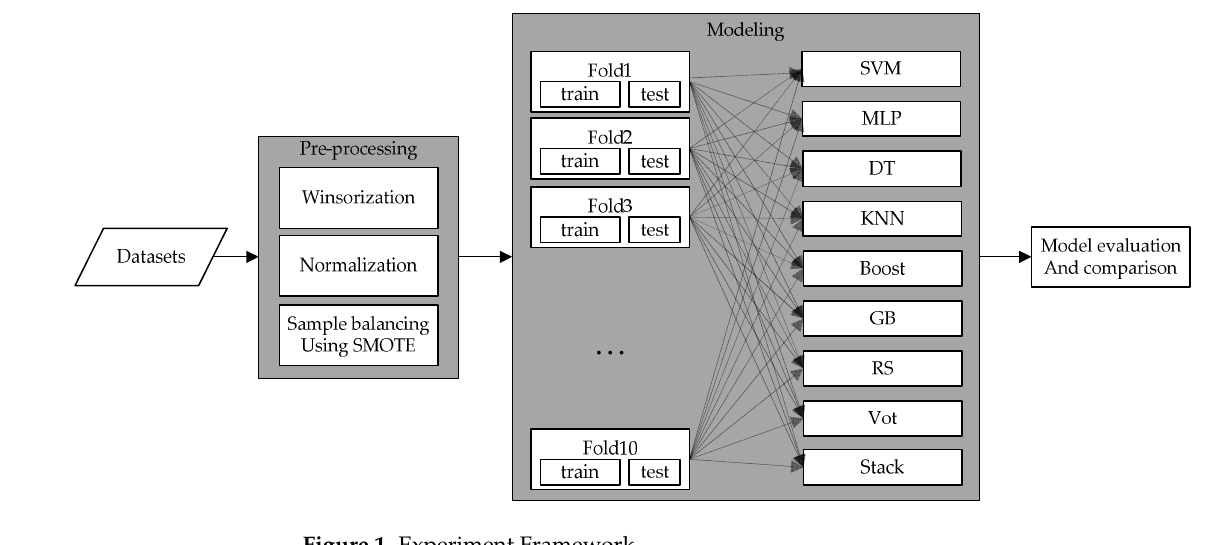
Figure 1. Experiment Framework.